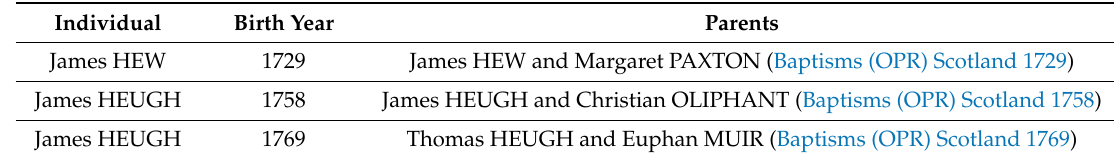
Table 2. Candidates for Katherine DOIG’s